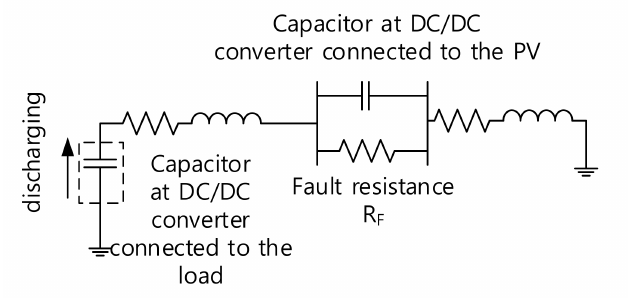
Figure 6. Equivalent circuit at fault on the DC side of the AC/DC converter.